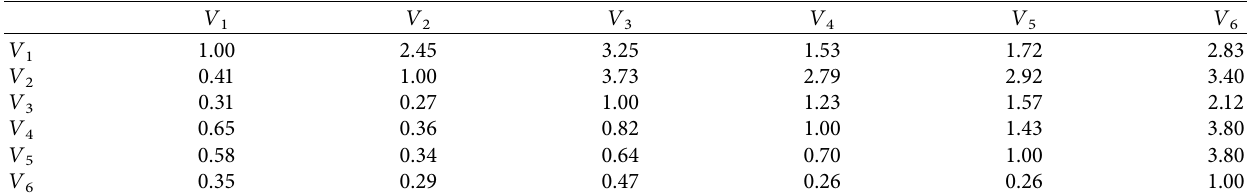
Table 3: Pairwise comparison on environmental subfactor.